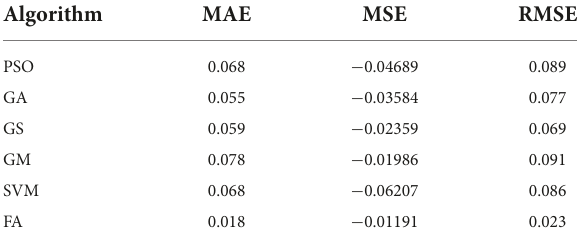
TABLE 3 Taxation forecast error results.